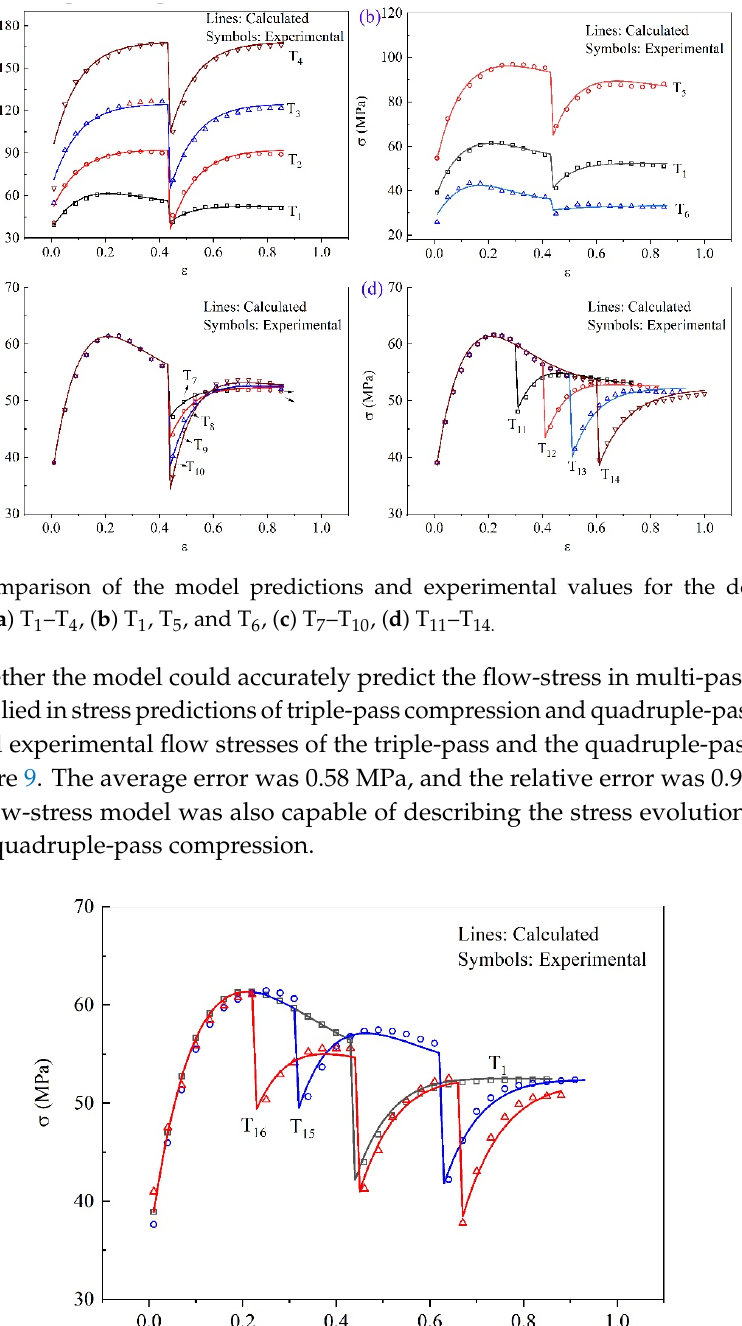
Figure 9. Comparison of the calculated and experimental flow stresses for the triple-pass compression and the quadruple-pass compression of 300M steel.